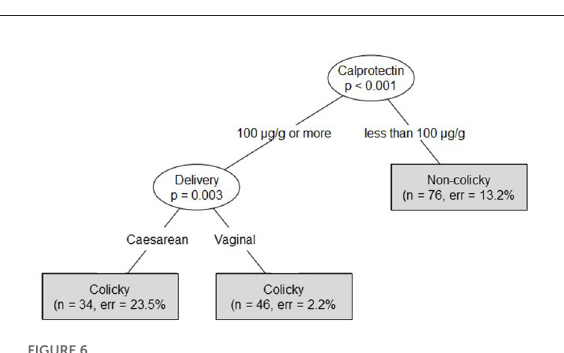
FigShare at: https://figshare.com/articles/dataset/Supporting_ the_Diagnosis_of_Infantile_Colic_by_a_Point_of_Care_